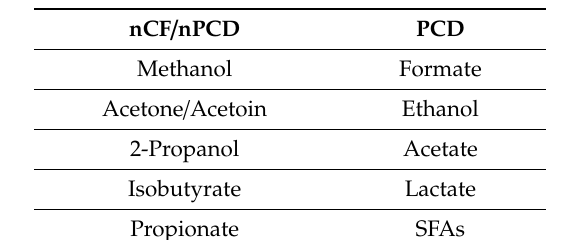
Table 4. Discriminating metabolites for the OPLS-DA model comparing data from subjects with nCF / nPCD and PCD bronchiectasis (see Figure 6 for details). Reported metabolites increase with respect to the other class a